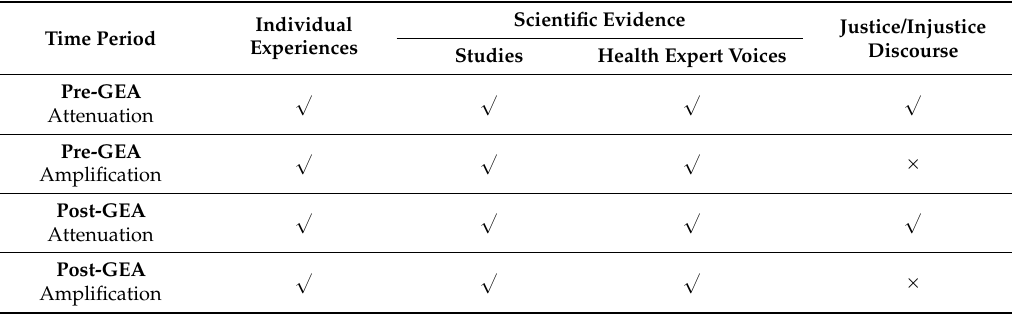
Table 1. Legitimation of wind turbine health effects.